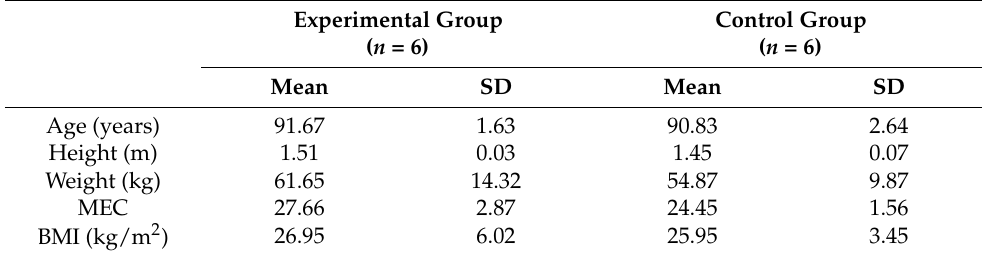
Table 1. Characteristics of the sample.